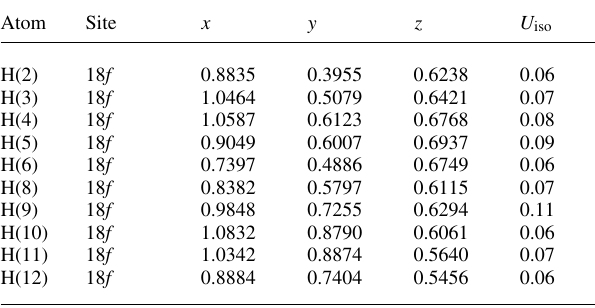
Table 2. Atomic coordinates and displacement parameters (in Å 2 )